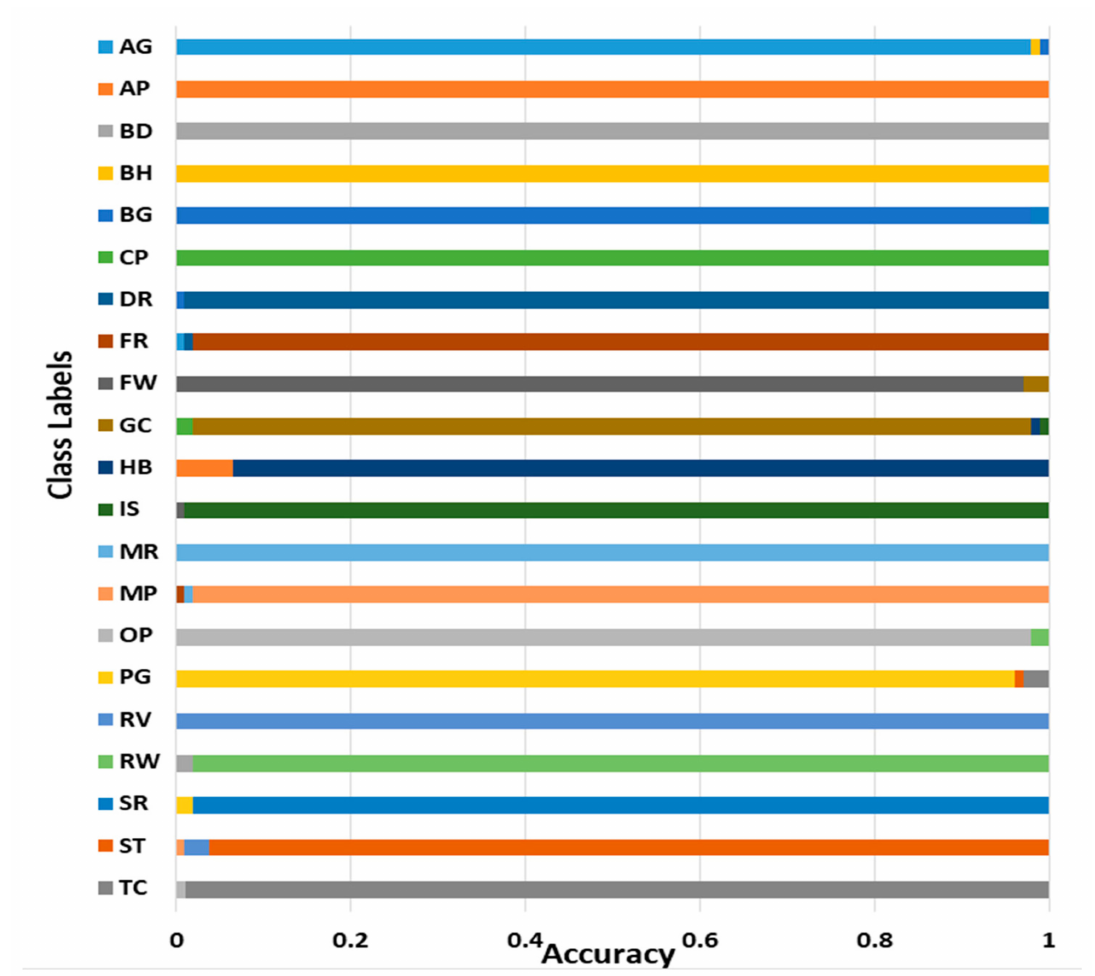
Figure 13. The recognition accuracy of OCSC model over UCM dataset. AG = agricultural; AP = air- plane; BD = baseball diamond; BH = beach; BG = building; CP = chaparral; DR = dense residential; FR = forest; FW = freeway; GC = golf course; HB = harbor; IS = intersection; MR = medium residential; MP = mobile home park; OP = overpass; PG = parking; RV = river; RW = runway; SR = sparse residential; ST = storage tank; TC = tennis